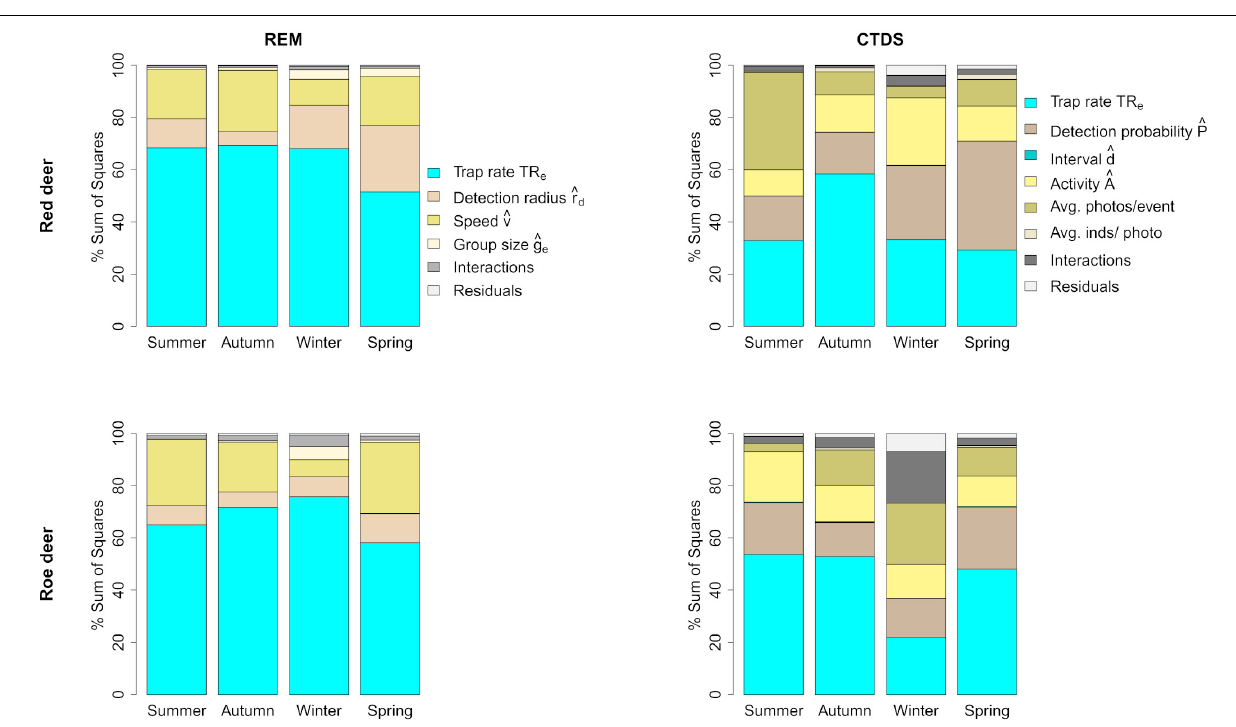
FIGURE 8 | Contributions of the model parameters to the uncertainty in REM- and CTDS-based population density estimates of red deer and roe deer as derived from data obtained from 108 camera traps, which were deployed for one year. The y axis shows the proportion of the total sum of squares attributable to the parameters, their interactions and the residuals in a linear regression with population density as the response variable and the input parameters as independent variables. For the REM, the trap rate TR e corresponds to the total number of events y divided by the total deployment days t . For CTDS, TR e multiplied by the average number of snapshot moments with animals (the first photos of the photo series) per event and the average number of individuals per snapshot moment equals n/T